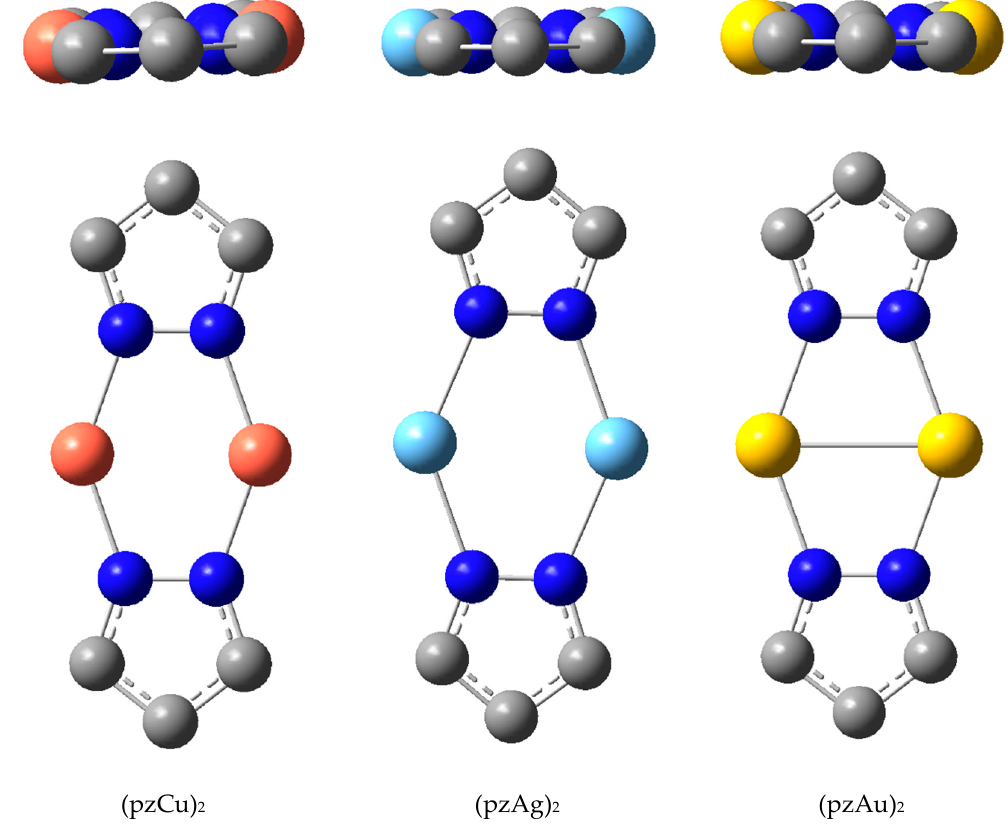
Figure 13. Two views of the calculated Cu, Ag and Au dimers; hydrogen atoms have been omitted. Table 2. Calculated mean metal ··· metal and metal ··· N atom (Å) (averaged and parent